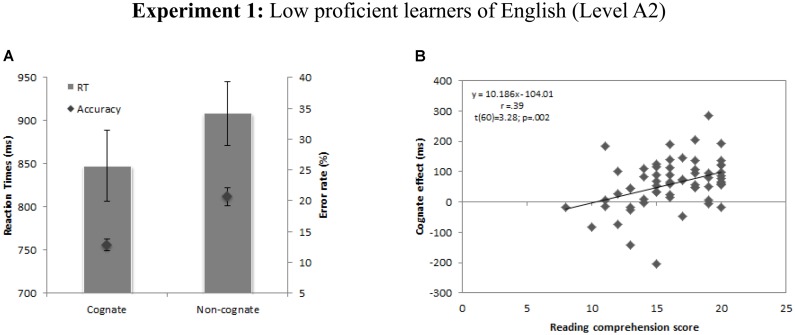
(A) Mean latencies and error rates for cognate and non-cognate words in Experiment 1. Error bars represent 95% confidence intervals. (B) Correlation between individuals’ cognate effects and reading comprehension scores for A2 group of English learners.